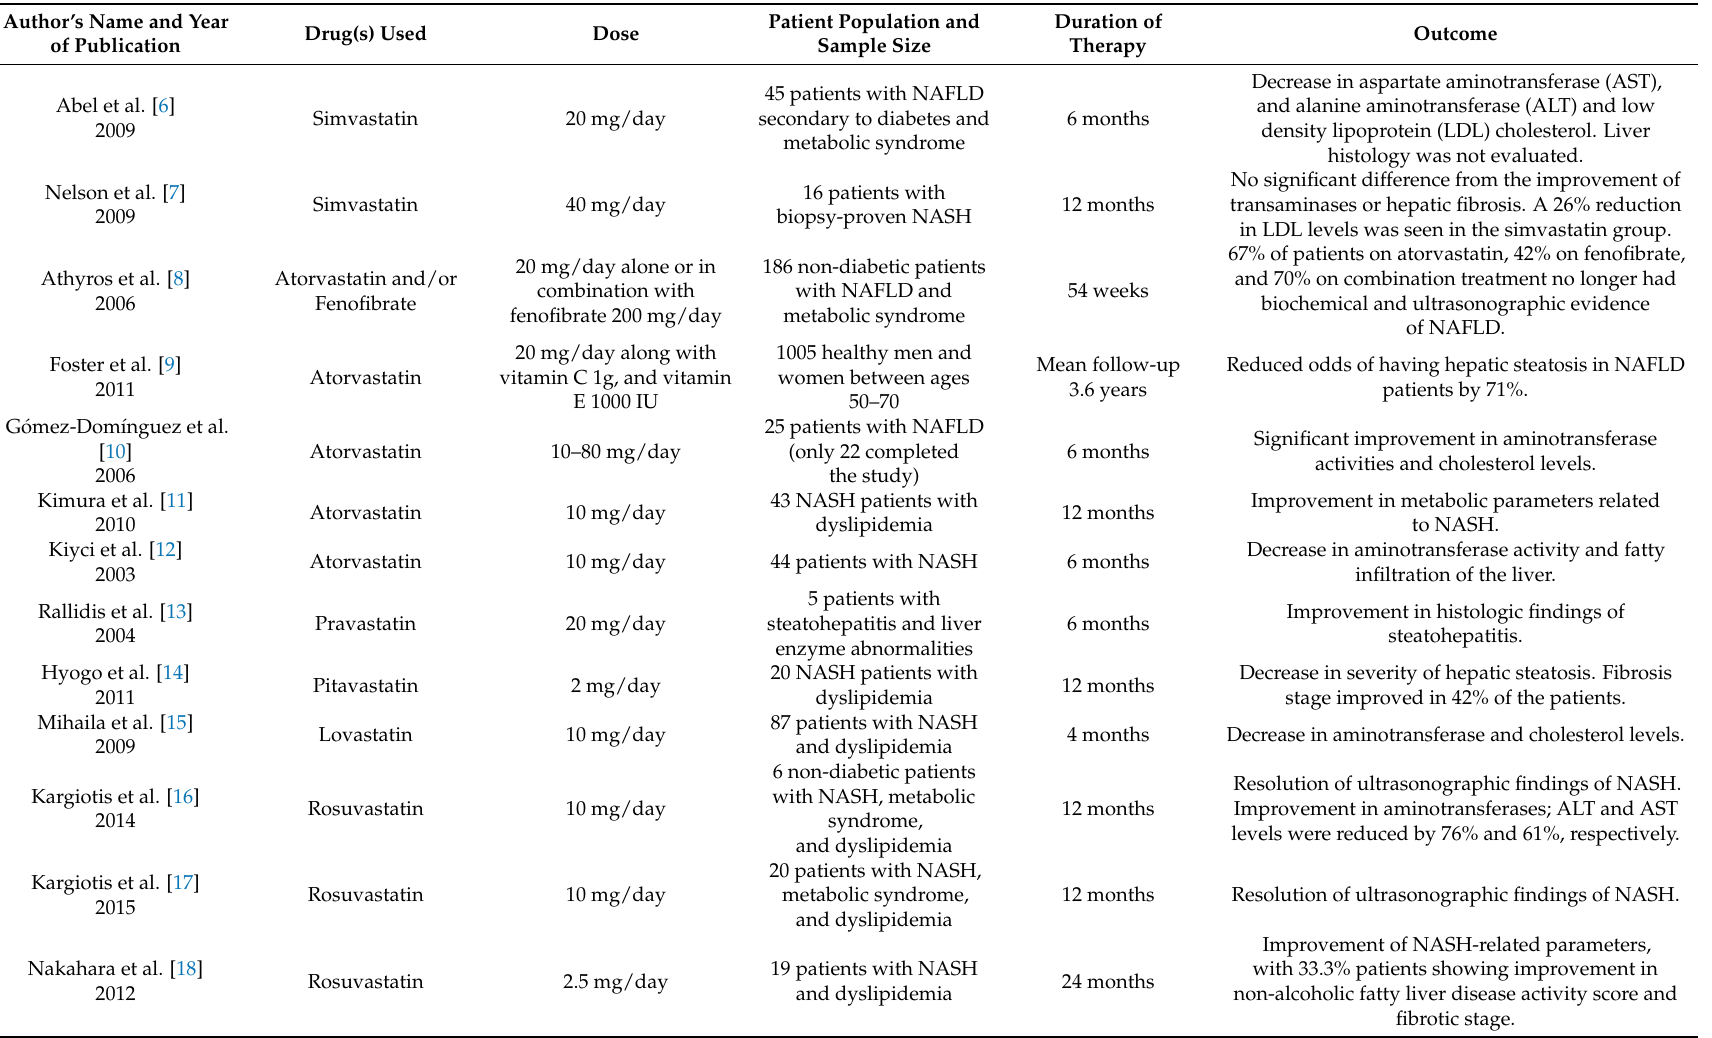
Table 1. Studies evaluating the utility of Statins in non-alcoholic fatty liver disease (NAFLD)/ non-alcoholic steatohepatitis